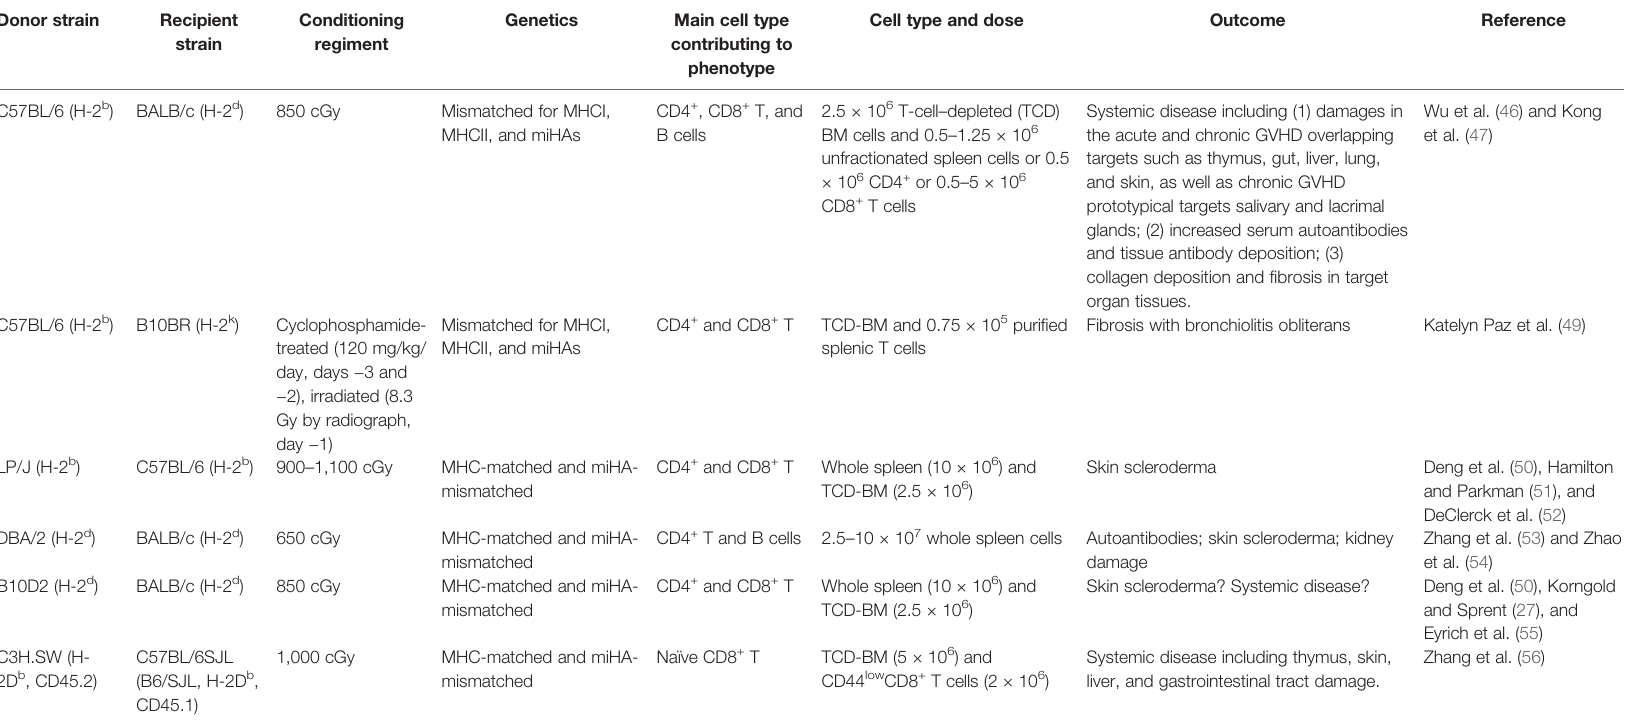
TABLE 1 | Summary of murine models of